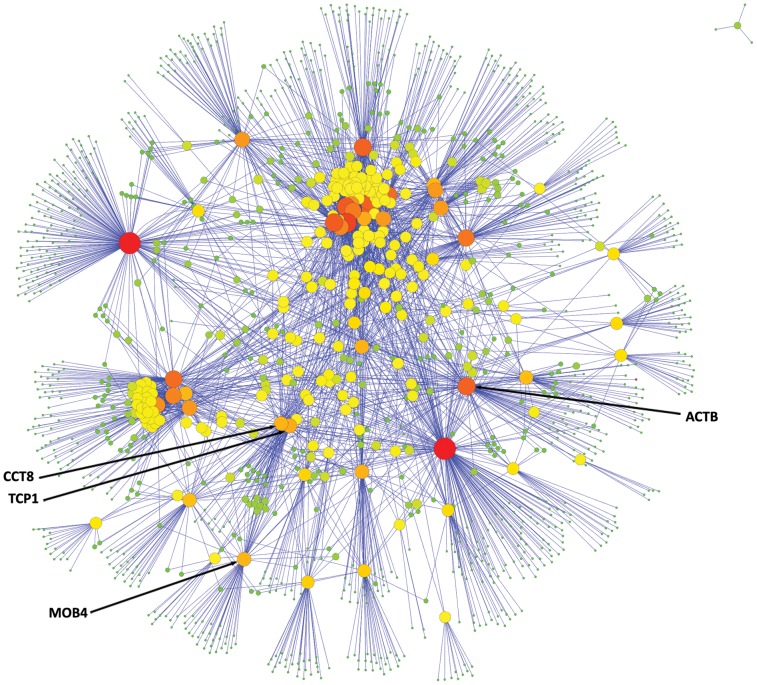
Worm genes +1 interactome.The +1 interaction network for the human orthologues of the 60 worm genes that were highlighted in our worm RNAi screen. For the 60 worm-screen genes with human orthologues, there were 3191 interactions in the +1 interactome.